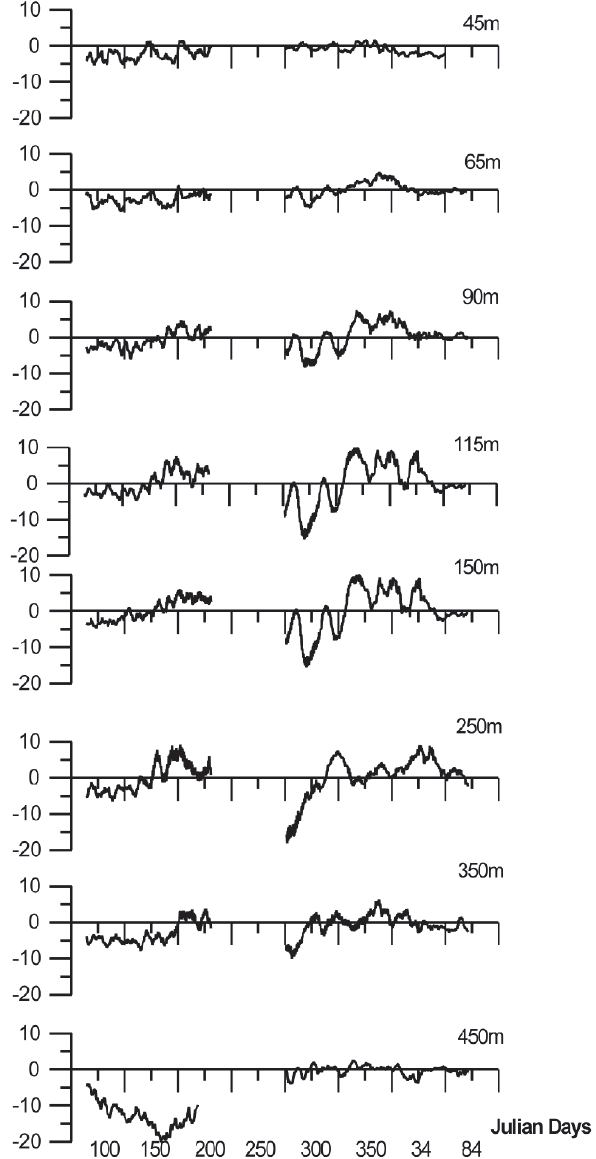
Fig. 10. Vertical velocities (mm/s) at different levels recorded by the ADCP for the whole period of measurements (04 March 2000 – 01 March 2001; J.D. 64 – J.D.